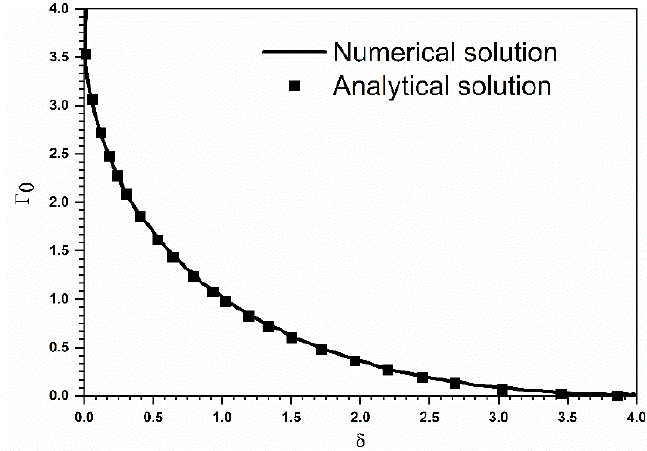
Figure 7. Comparison of Analytical and Numerical solutions of Γ 0 ( δ ) function.